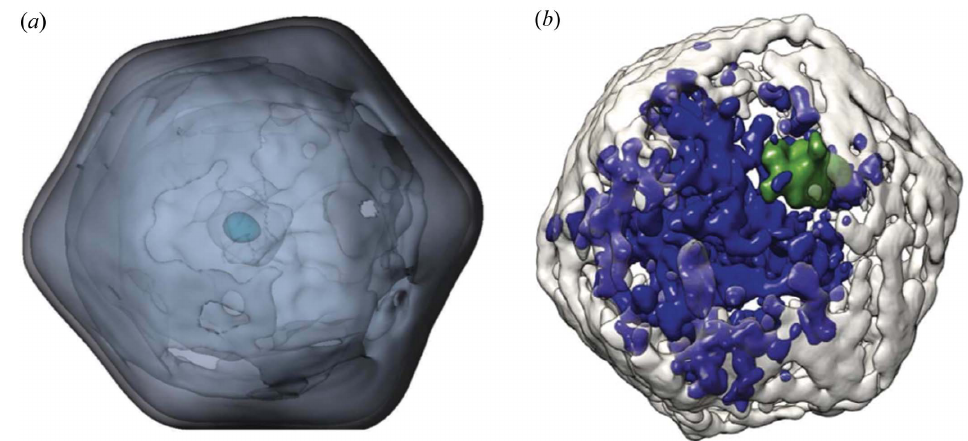
Figure 1 Single-particle three-dimensional imaging of Melbourne virus (MelV). ( a ) A reconstructed image from XFEL single-particle three-dimensional imaging. ( b ) An MelV image obtained from cryoEM tomographic reconstruction for comparison with panel ( a ). Reproduced with permission from Okamoto et al. (2018) under a Creative Commons Attribution 4.0 International License,